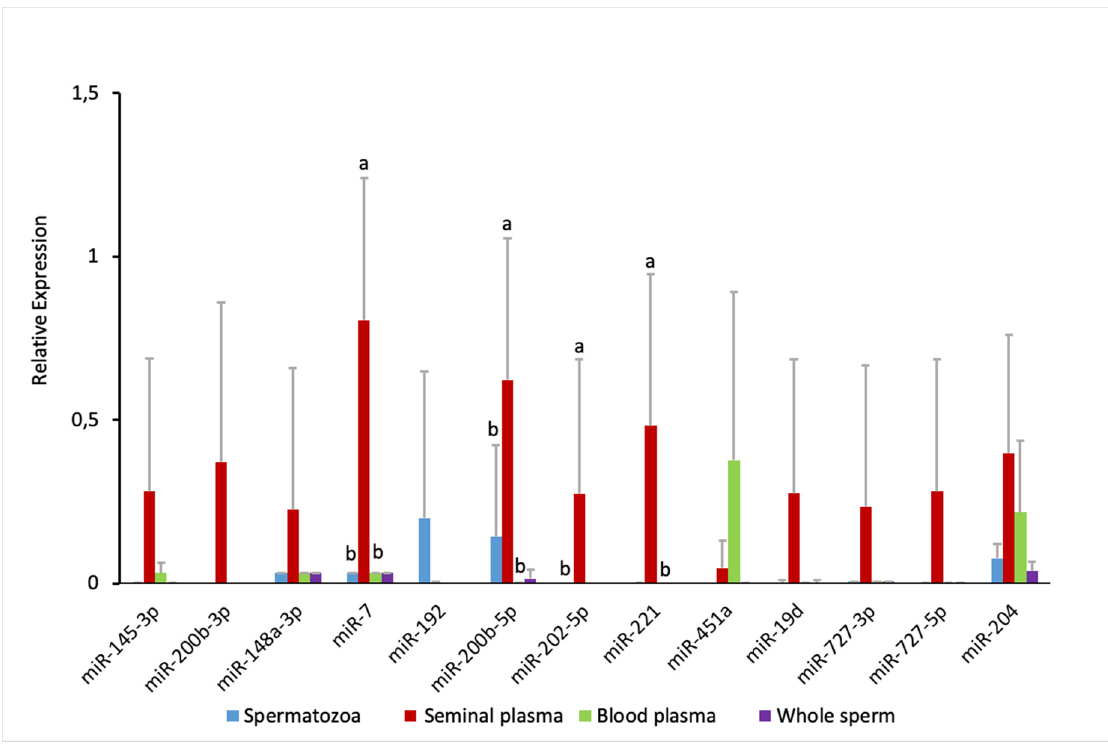
Figure 6. RT-qPCR for selected miRNAs in the blood plasma versus the whole sperm and its fractions (spermatozoa and seminal plasma). Relative expression values were obtained after normalizing to miR-429 expression. Average values are given ( n = 6). Bars represent standard deviations. Different letters indicate significant differences at p < 0.05.